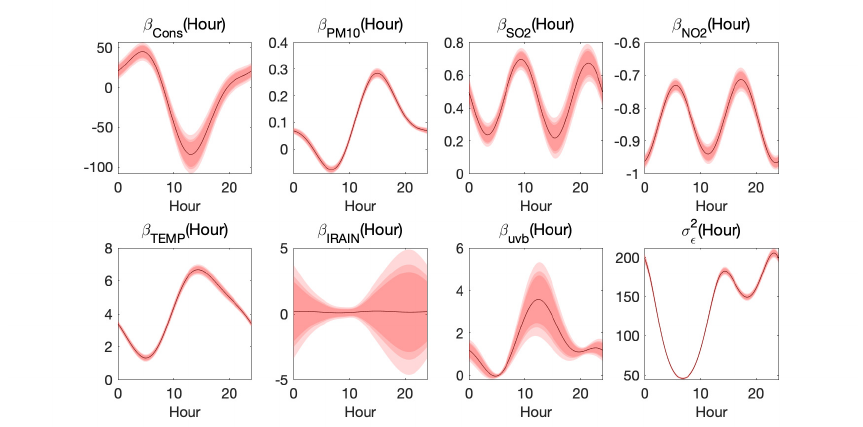
Figure 6. Estimated β cons ( hour ) , β PM 10 ( hour ) , β SO 2 ( hour ) , β NO 2 ( hour ) , β TEMP ( hour ) , β IRAIN ( hour ) , β UVB ( hour ) and σ 2 (cid:101) ( hour ) , with 90%,95%, and 99%- confidence bands.